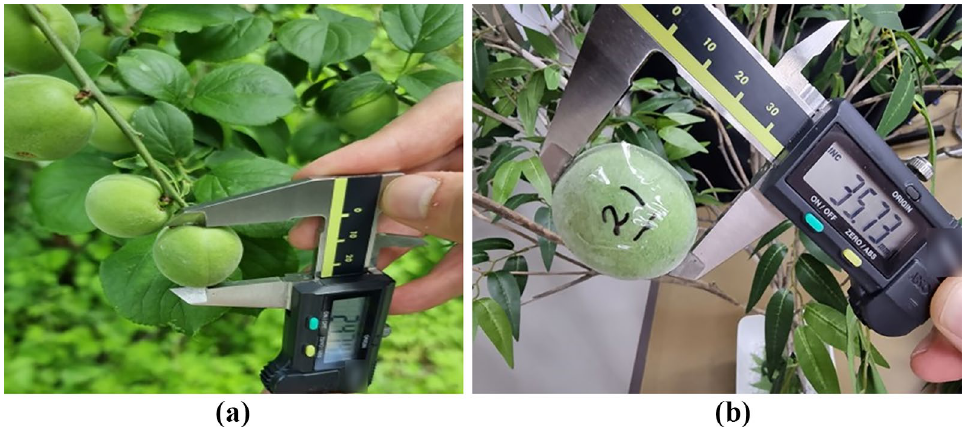
Figure 12. Diameter measurement of prunus mume fruits with Vernier Caliper: ( a ) actual outdoor fruits; ( b ) indoor artificial fruits.